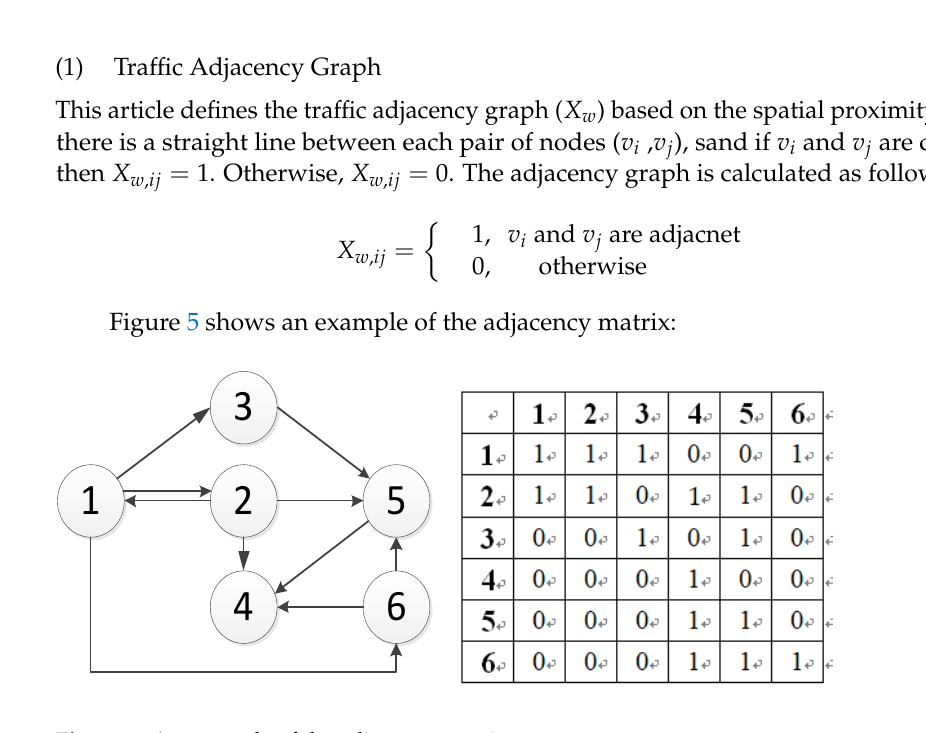
Figure 5. An example of the adjacency matrix.